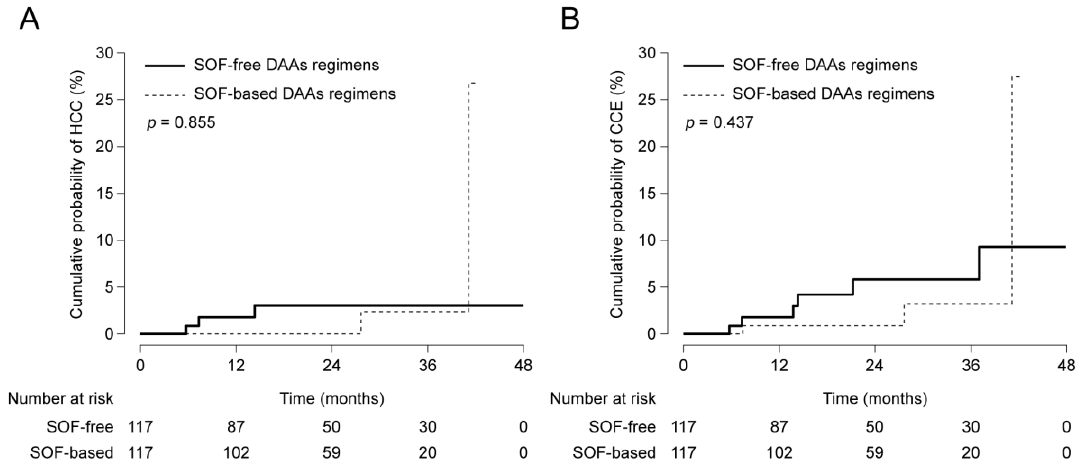
Figure 4. Cumulative probabilities of HCC ( A ) and CCE ( B ) development between patients treated with SOF-based and SOF-free DAAs regimens after PS matching analysis.